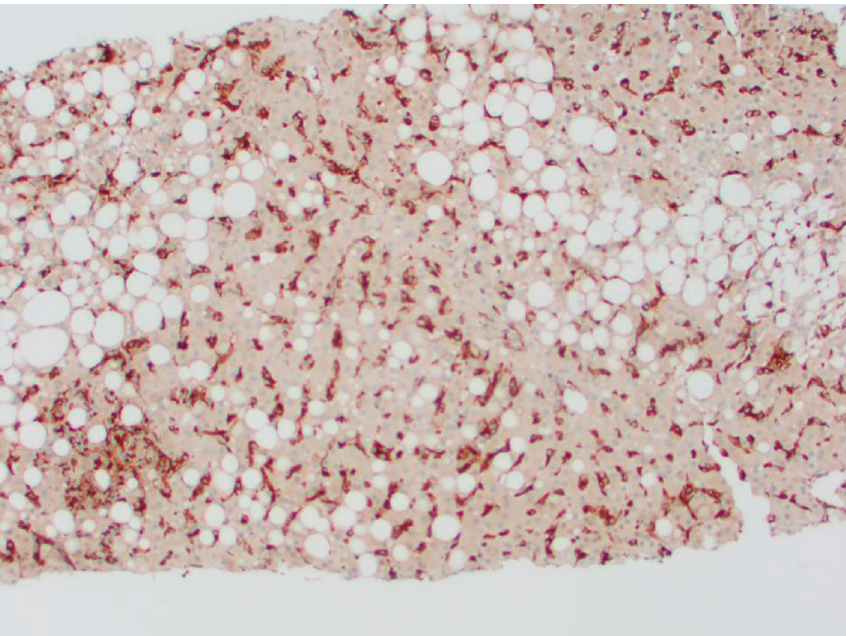
Figure 3: Immunohistochemical staining of CD68-positive macrophages/Kupffer cells (brown stain) in the liver. An excessive number of macrophages are located in sinusoids.